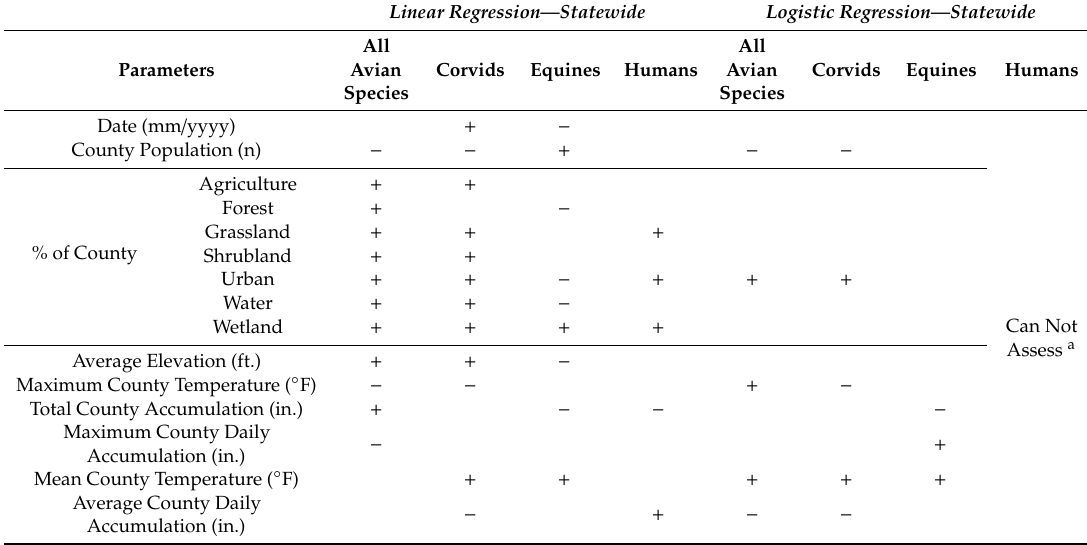
Spatial autocorrelation indicated by Moran’s I, with resulting significance factor and spatial interpretation (asterisk (*) denotes significant factor for p < 0.05). Table 5. Summary of significant parameters ( p < 0.0001) for statewide WNV modeling, evaluated by linear and logistic regression methods. All factors indicated by an increase ( + ) or decrease ( − ) symbol display their respective e ff ect on WNV